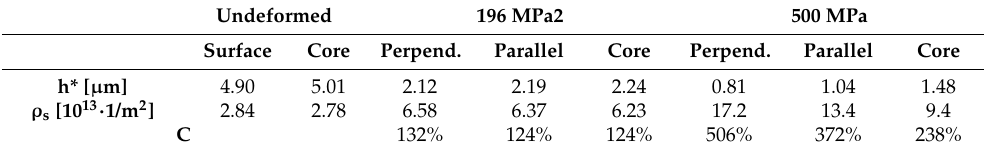
Table 1. Results obtained using Nix and Gao model with the micro-indentation